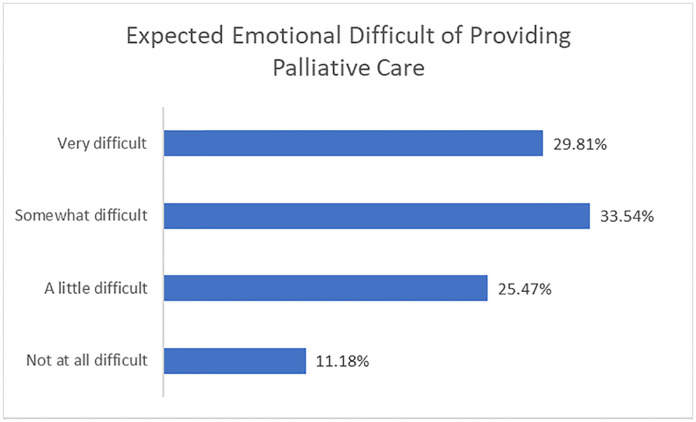
Expected emotional difficulty of providing palliative care.Expected emotional difficulty of providing palliative care to patients under pandemic conditions, measured on a 4-point scale from not at all difficult to very difficult.